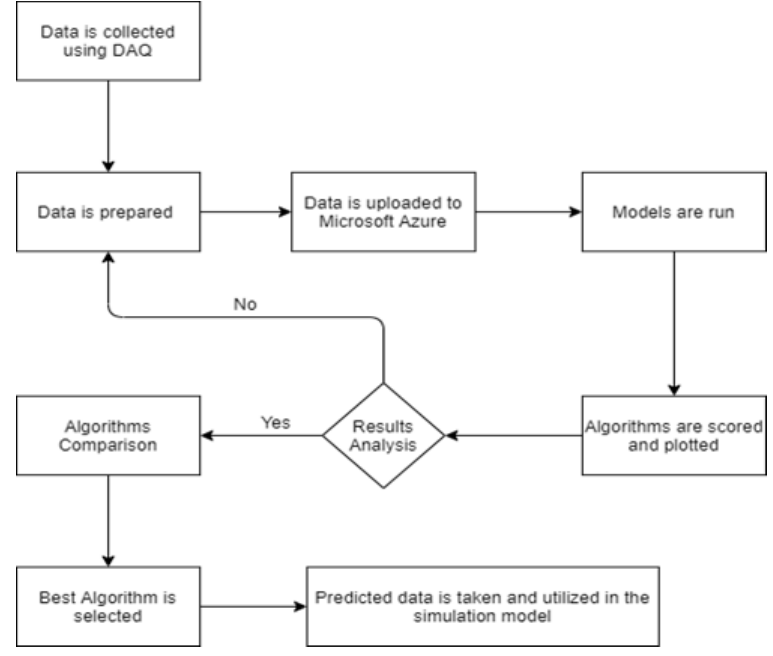
Figure 3. Flowchart of PdM time slots